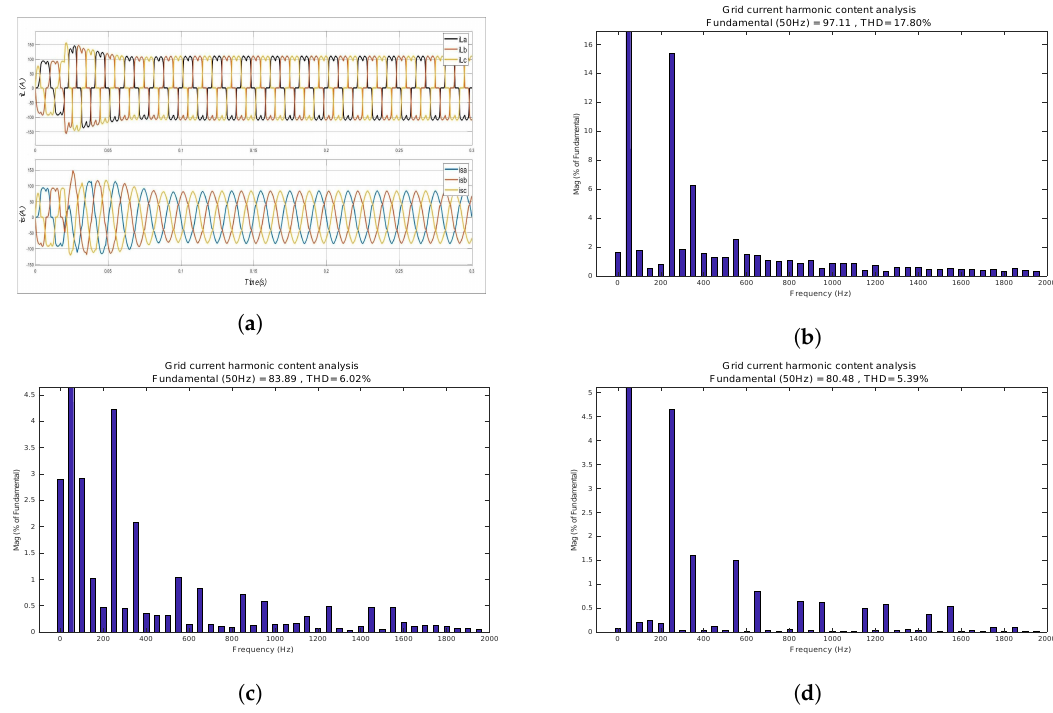
Figure 10. Scheme II: ( a ) nonlinear load current and the grid current; ( b ) the FFT result of the grid current at the 0 s; ( c ) the FFT result of the grid current at the 0.07 s; ( d ) the FFT result of the grid current at the 0.15